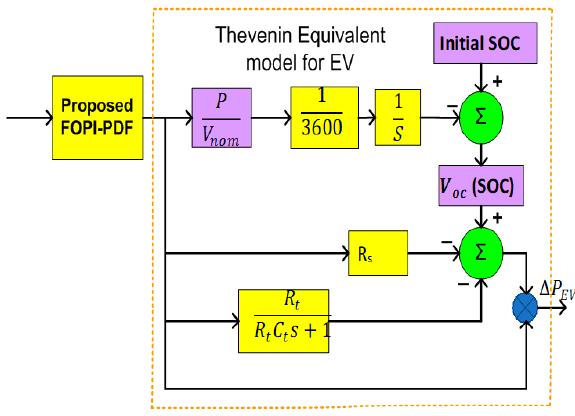
Figure 3. Dynamic model of EV system.